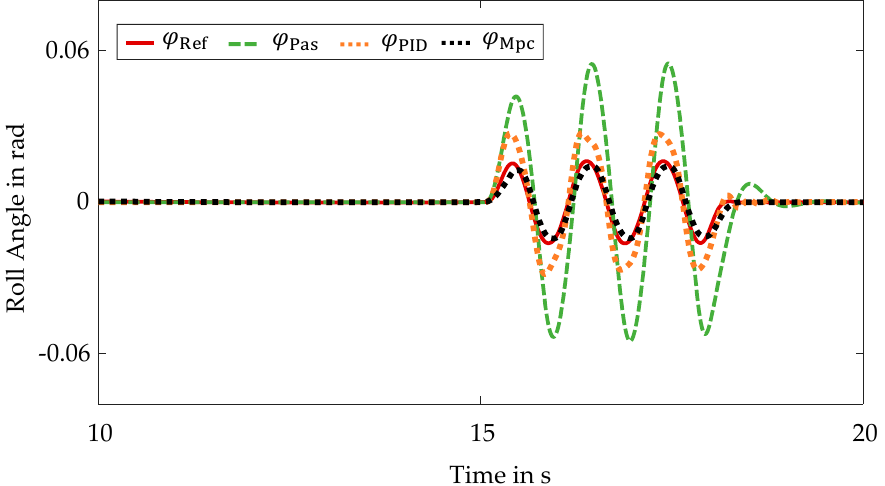
Figure 9. Control Quality Sinusoidal Steering–Roll Behavior–Roll Angle Curves.